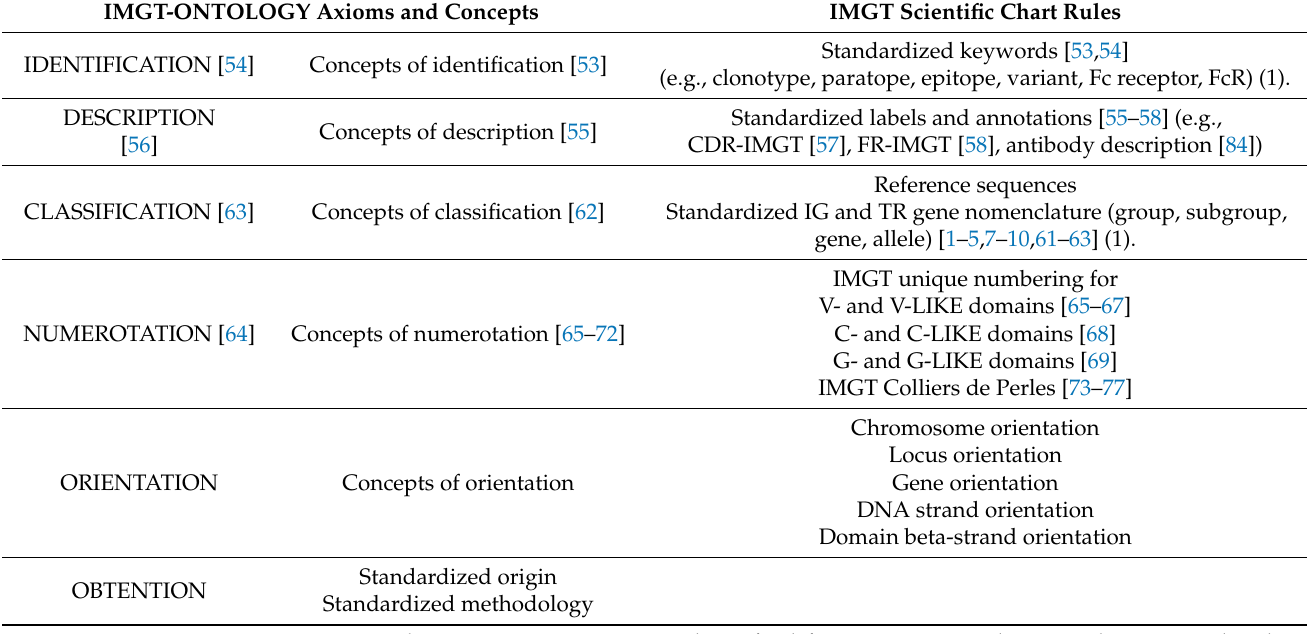
Table 2. IMGT-ONTOLOGY axioms, concepts and IMGT Scientific chart